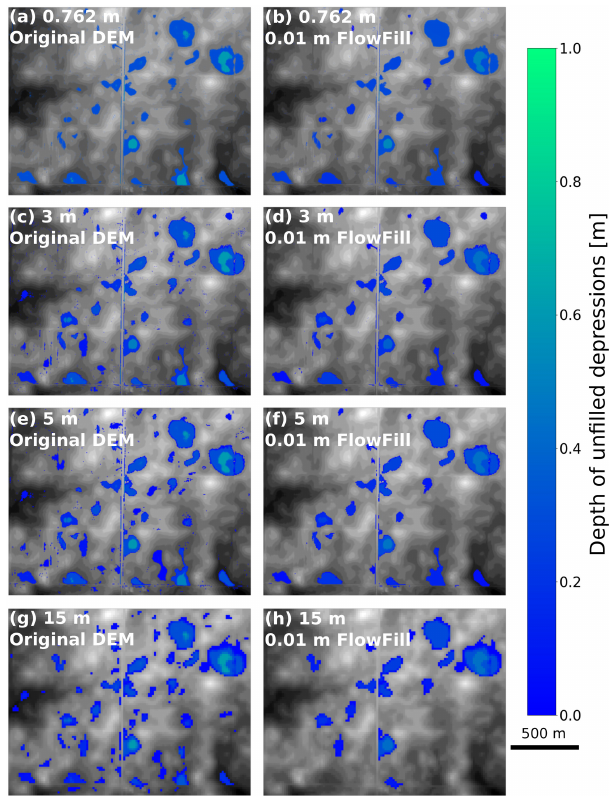
Figure 13. Drainage networks in a subsection of the Sangamon study area at several different resolutions. Flow networks were cre- ated using the FlowAccumulation method included in RichDEM (Barnes et al., 2014a; Barnes, 2016) with the result masked to show only cells with a flow accumulation greater than 500m 2 . The origi- nal, unfilled DEM supported very little drainage and is not pictured here. On the left are the fully connected drainage networks occur- ring over a completely filled flow-routing surface. On the right are the partially connected networks resulting from the partially filled surfaces created using FlowFill and 1cm of starting runoff. The un- filled depressions associated with the right-hand column are shown in Fig. 12. The colours indicate the amount of flow accumulation in stream channels (m 2 ). The main river channels are consistently present at all